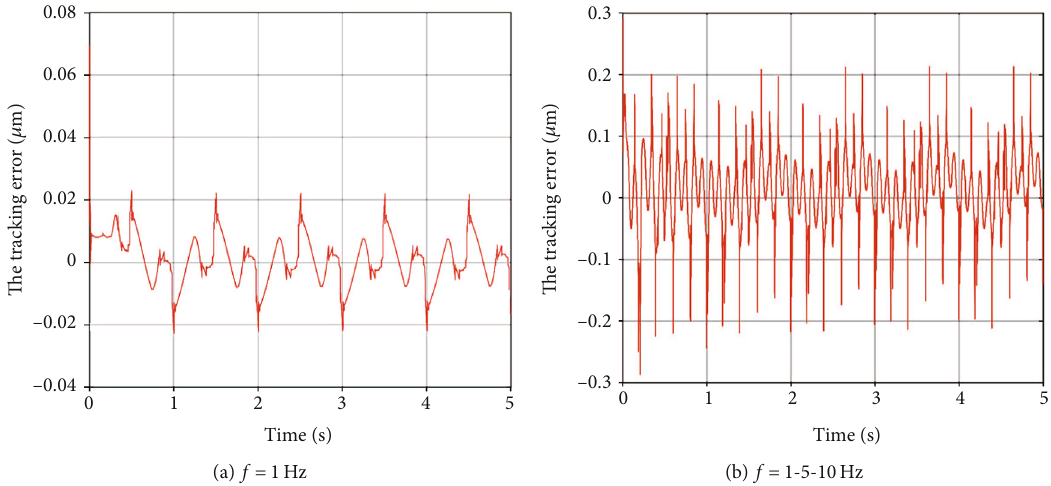
Figure 6: The tracking result of adaptive compound control.